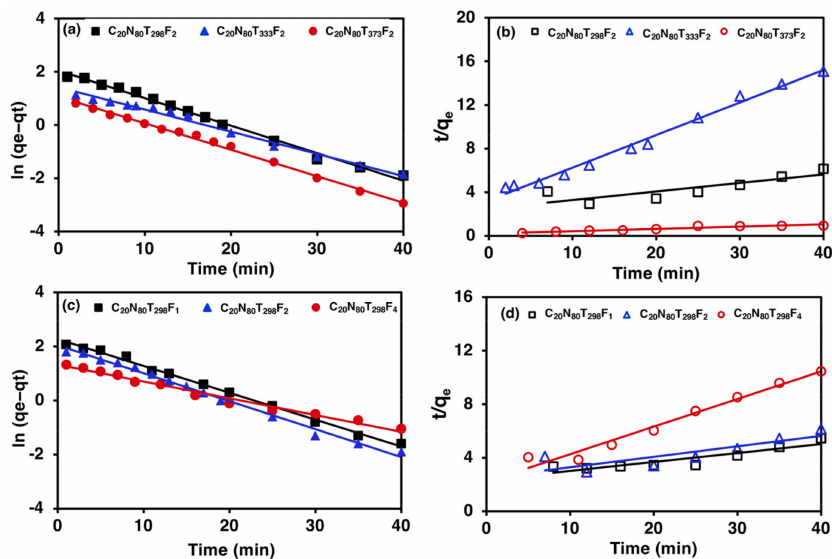
Figure 6. Kinetic parameters models of CO 2 adsorption using zeolite 5A: ( a ) PFO model at different temperatures; ( b ) PSO model at different temperatures; ( c ) PFO model at different feed flow rates; ( d ) PSO model at different feed flow rates. Table 4. Kinetic parameters of CO 2 adsorption from 20/80 %vol of a CO 2 /N 2 gas mixture using zeolite 5A at different